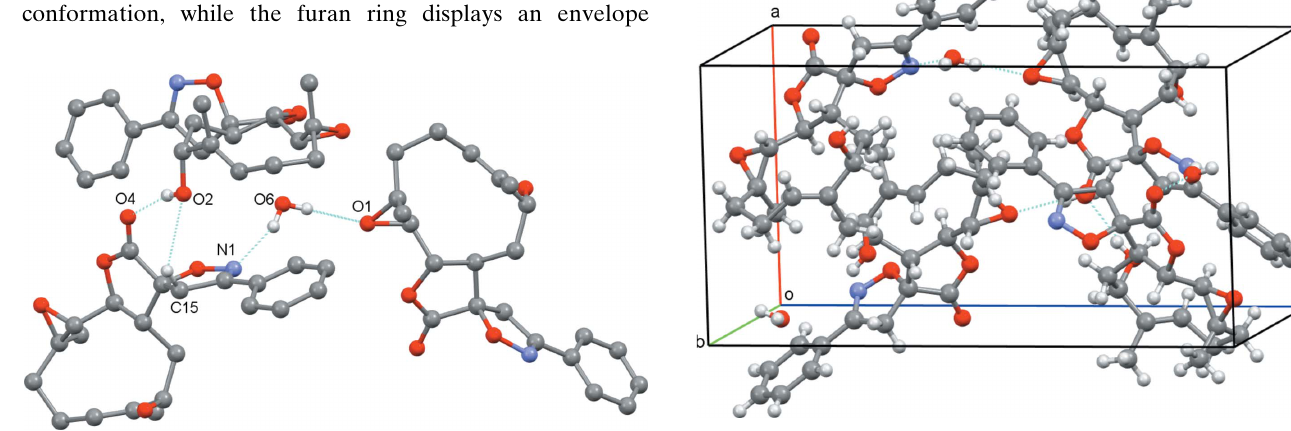
Figure 3 The crystal packing for the title compound, showing molecules linked by hydrogen bonds (dashed cyan lines).